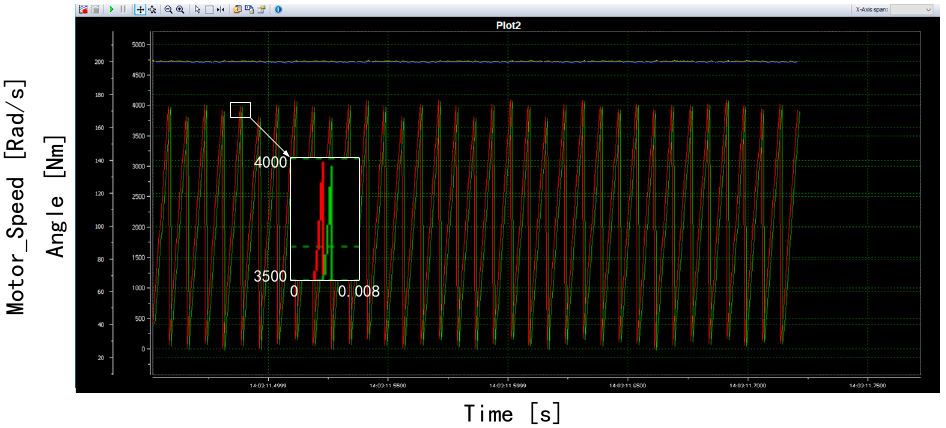
Figure 25. The comparison chart of the motor speed and rotor position of the new and improved SMO observer at 200 rad/s.